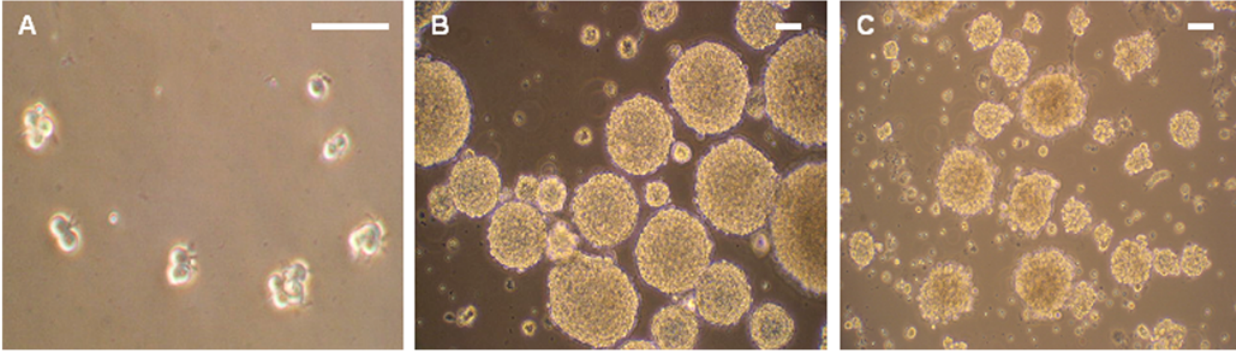
Figure 1. Morphology of hypothalamic-derived NS, phase-contrast images. A, Dividing cells after 2 days in vitro (2DIV). B, Fetal hypothalamic NS after 7DIV. C, Adult hypothalamic NS after 7DIV. Scale bars: 50 m m.